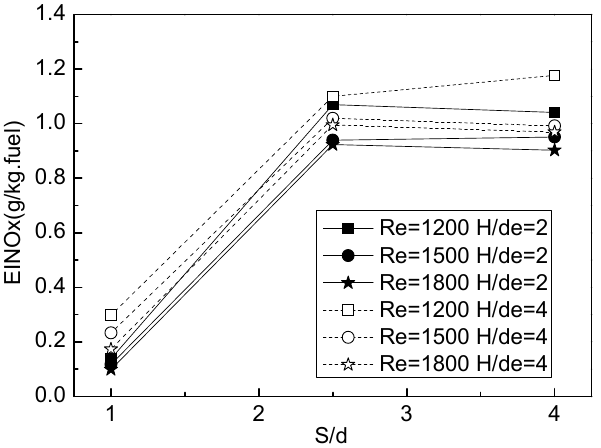
Figure 7. EINO x of slot LPG premixed flame array at different conditions. The EINO 2 variations of flame array at different conditions are compared in Figure